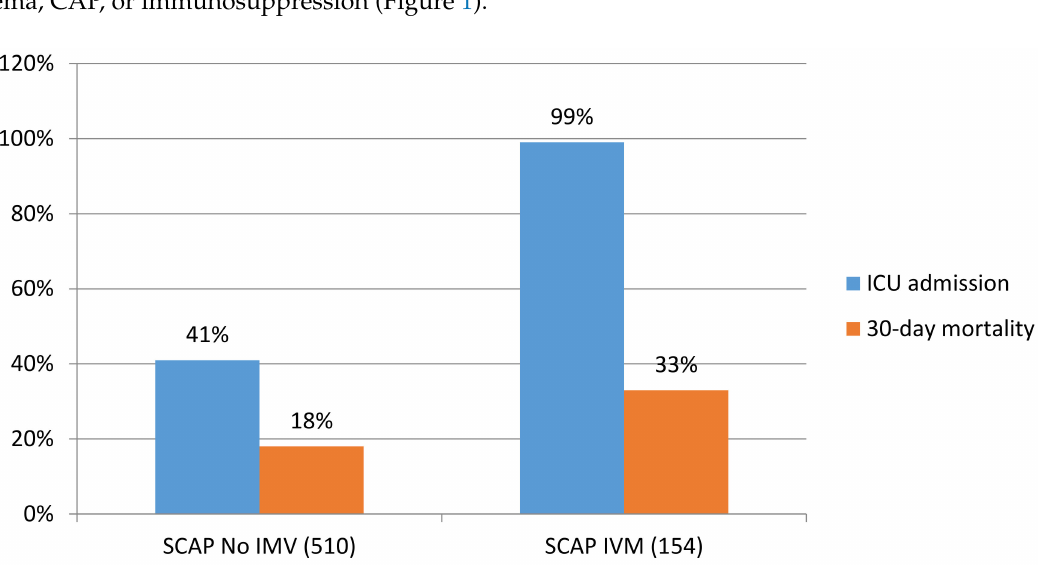
Figure 1. The outcomes in patients with severe community-acquired pneumonia (SCAP) with non-invasive ventilation (NIV) and invasive mechanical ventilation (IMV). Intensive care unit (ICU). X–axis showed the percentage and y-axis showed study population. Adapted from Reference